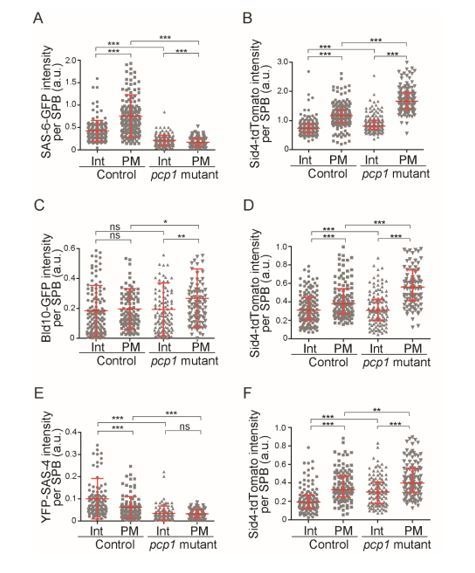
Intensity of Sid4 is increased in the pcp1 mutant.(A-F) Quantification of the intensity of the centriole proteins and Sid4-tdTomato per SPB in the indicated conditions. B, D and F correspond to A, C, and E.Means ± s.d. are shown in red (ns-not significant, * p<0.05, ** p<0.001, *** p<0.0001, Mann-Whitney U test).